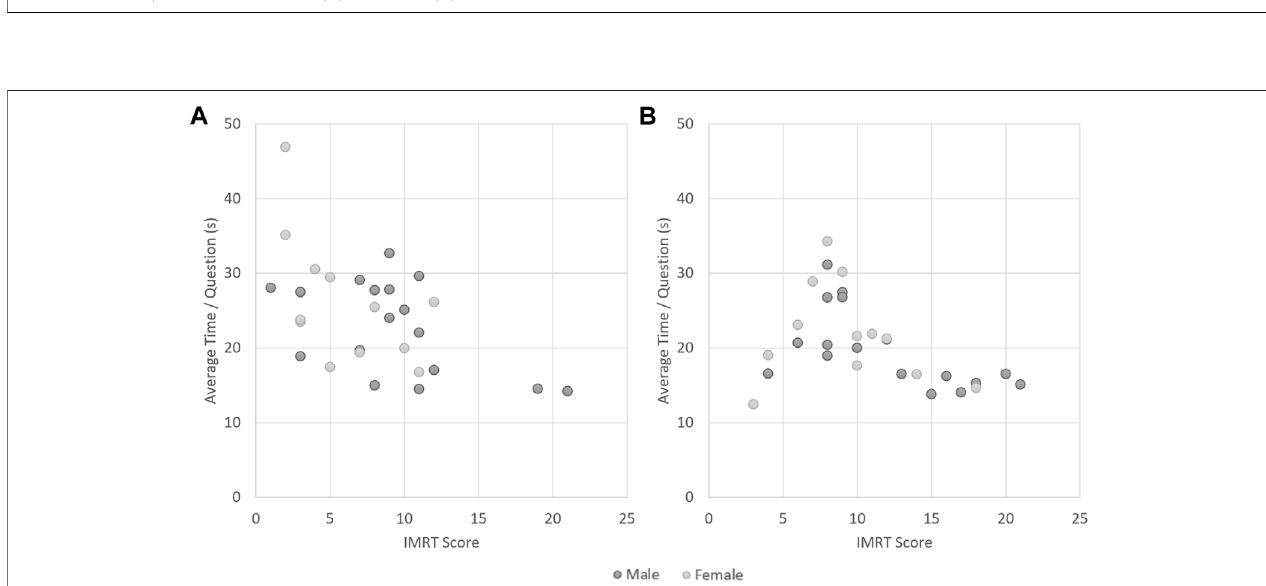
FIGURE 9 | Comparing the relationship between speed (average time/question) and accuracy (score) for the (A) 2D IMRT and (B) 3D IMRT.